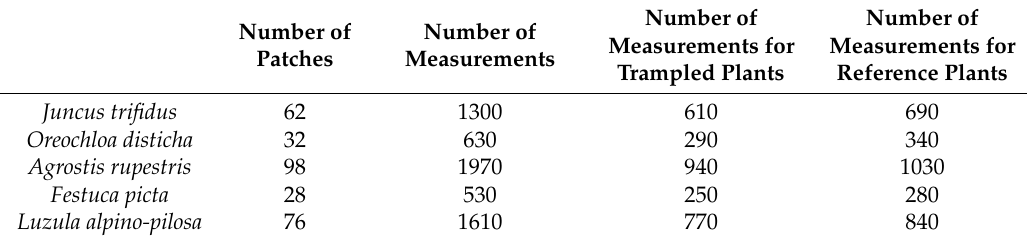
Table 1. The number of research targets and